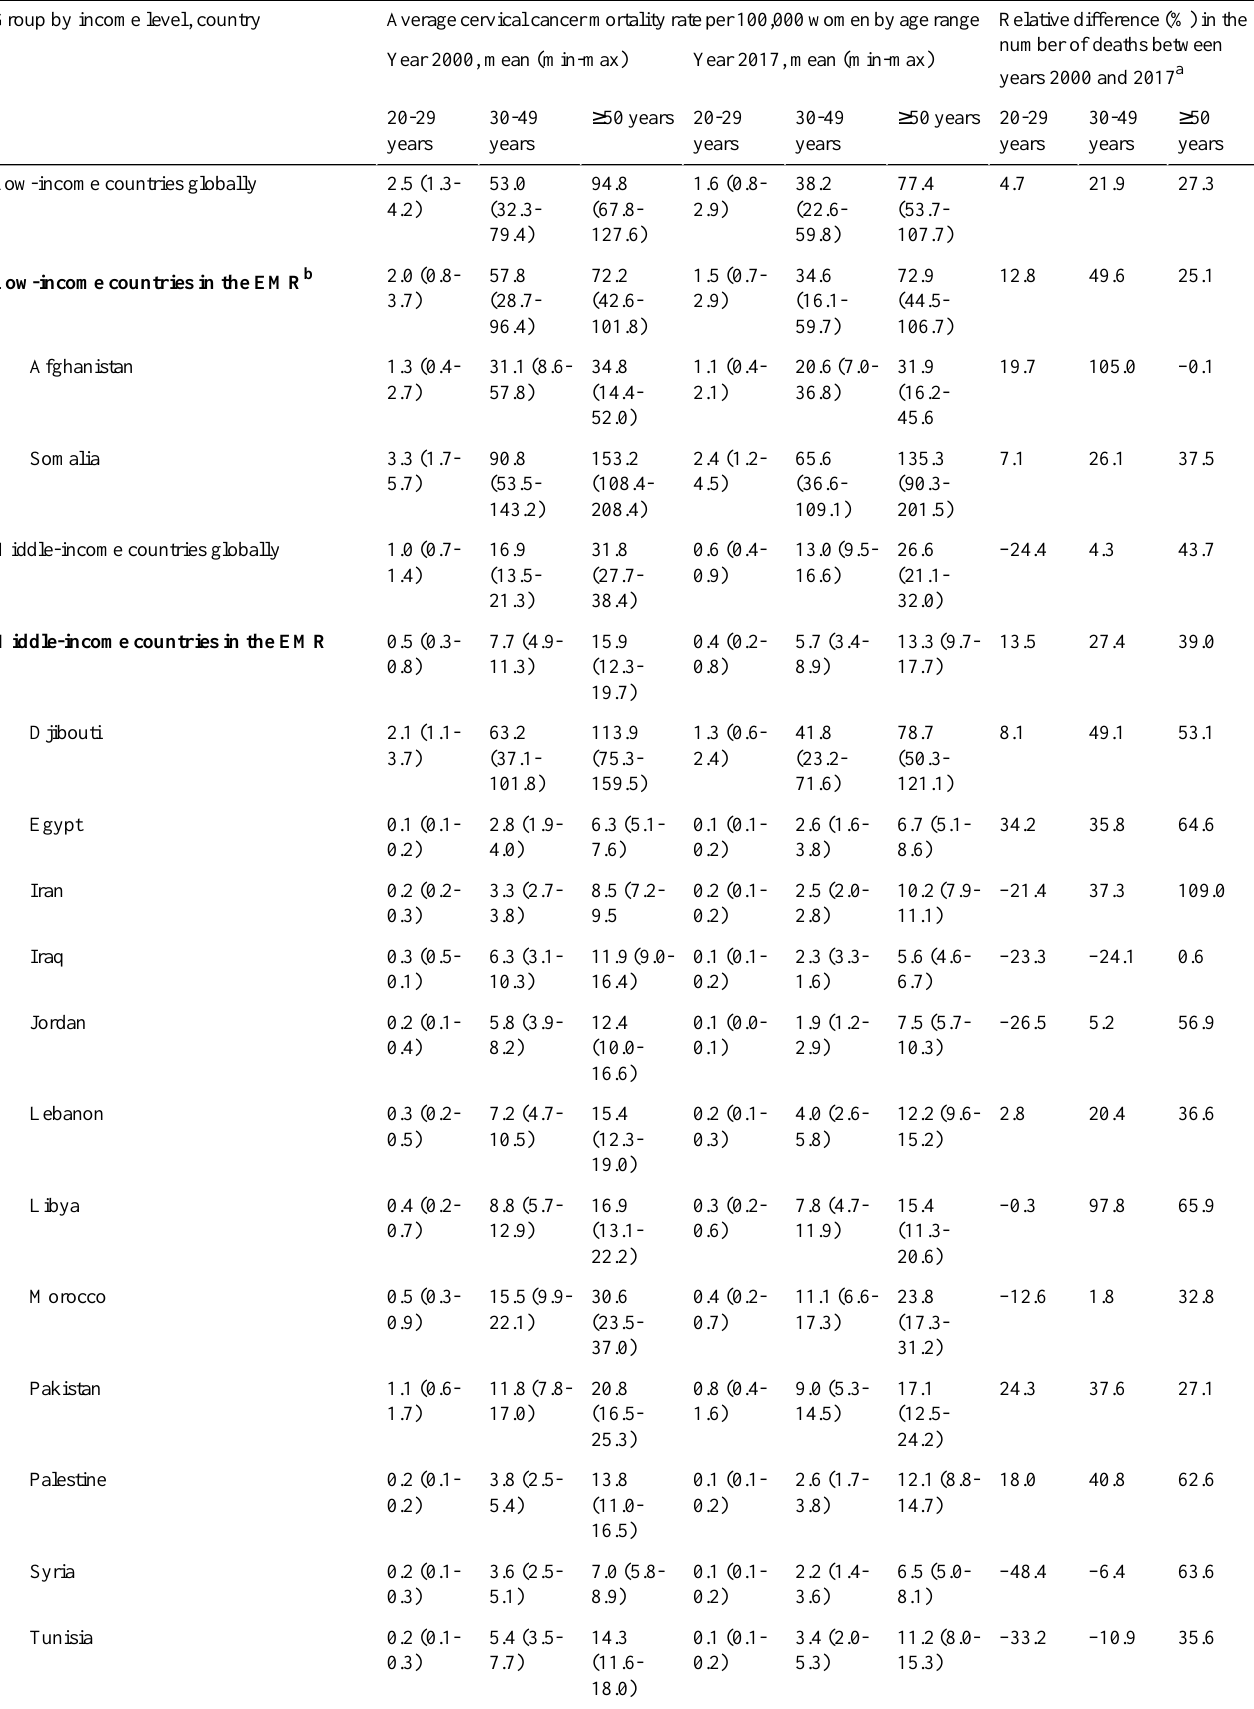
Table 3. Cervical cancer mortality rates among women older than 20 years in the Eastern Mediterranean Region by age, country, and income level compared to the global average in the years 2000 and